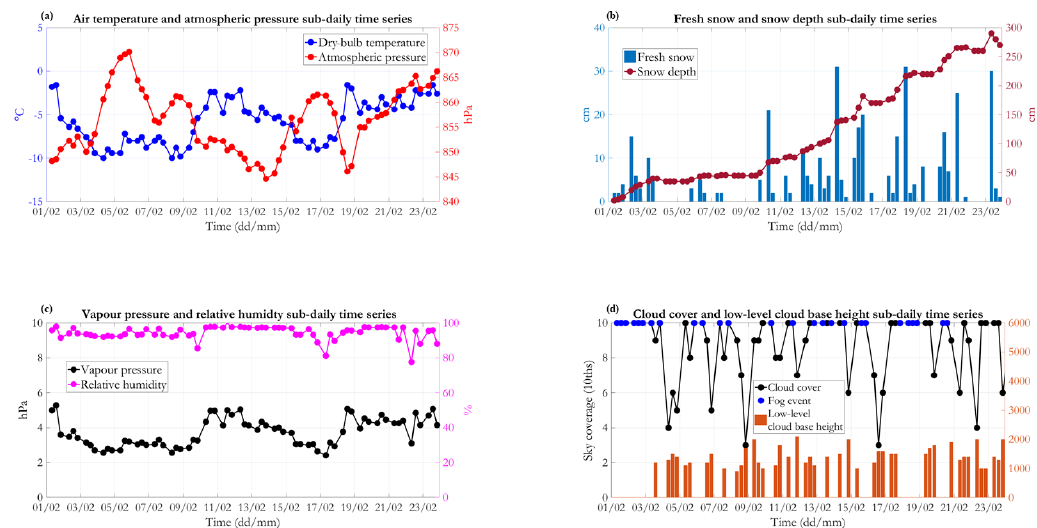
Figure 9. Sub-daily time series of different meteorological parameters observed from 1 to 23 February 1956. Panel (a) shows the dry-bulb temperature and atmospheric pressure. Panel (b) presents the fresh snow and snow depth records. Panel (c) shows vapour pressure and relative humidity. Panel (d) plots the cloud cover and low-level cloud base height observations. It should be noticed that such data were subject to a quality control procedure that did not include the